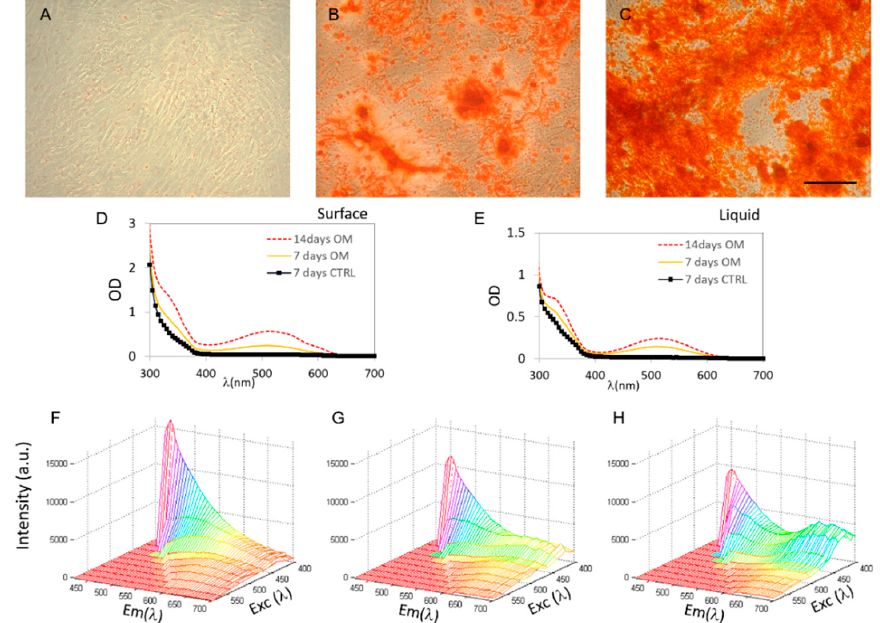
Figure 1. Alizarin Red S (ARS) staining of calvarial-derived mesenchimal stem cells (CMSC) on transparent surfaces. CMSC after 7 days ( A ), 7 days after OM induction ( B ), 14 days after osteogenic medium (OM) induction ( C ). The scale bar for Figure 1A–C is reported in Figure 1C and the value is 50 µm. Adsorption spectra of samples obtained in situ ( D ) or after solvent extraction ( E ). Fluorescence 2D spectra are reported in ( F – H ) for 7 days, 7 days after OM induction, and 14 days after OM induction, respectively.